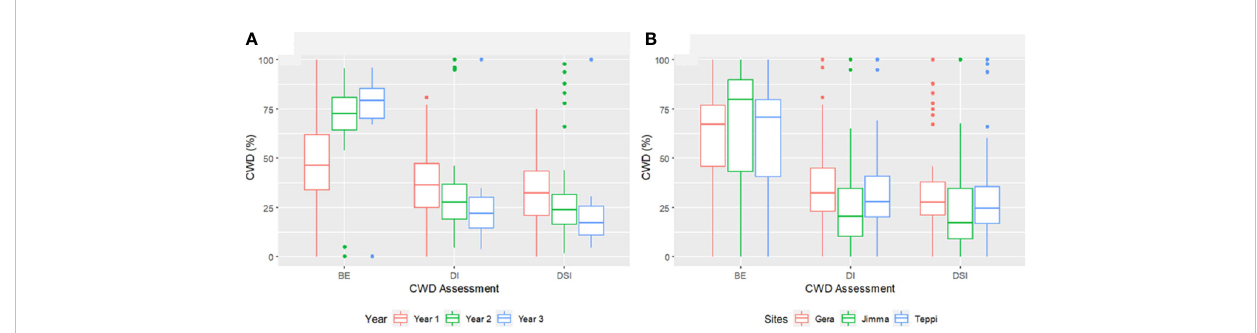
FIGURE 11 Boxplots summarizing the cumulated CWD assessments (A) across three years and (B) at different experimental fi eld sites. CWD, Coffee Wilt Disease; BE, Biocontrol Ef fi cacy; DI, Disease Incidence and DSI, Disease Severity Index. Year 1 = 2018/19, Year 2 = 2019/20 and Year 3 = 2020/21. The boundaries of the boxplot indicate the 25 th and 75 th percentiles, and the solid line within the boxes indicates the median